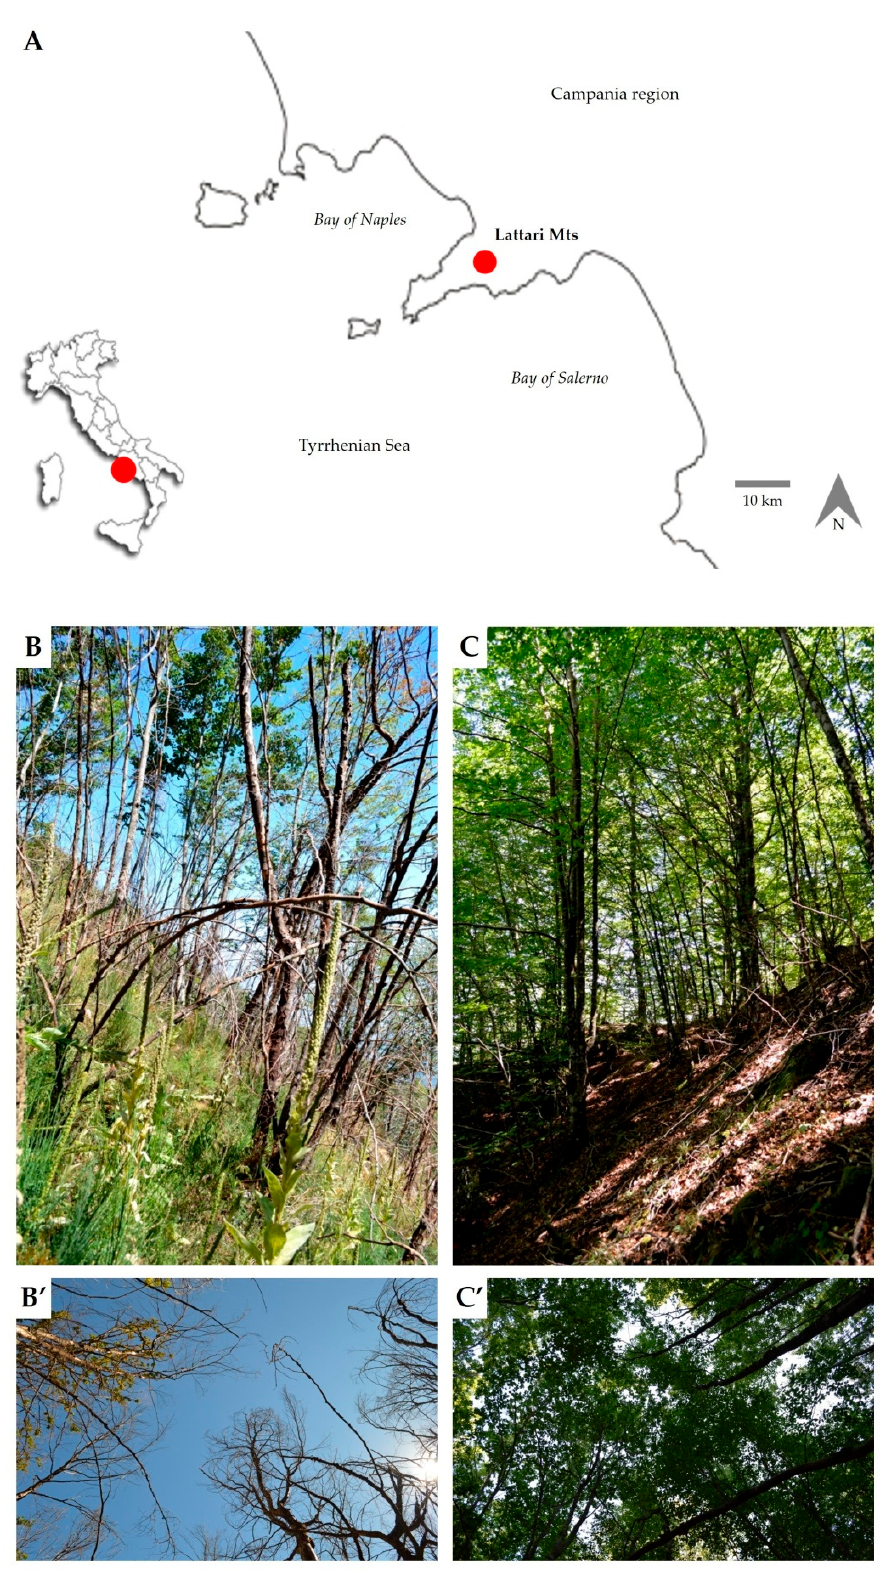
Figure 1. Location in southern Italy and Campania region (red circles) of the study area ( A ). Burned ( B ) and control ( C ) plots with related tree canopies ( B’ , C’ ) (photos by A.